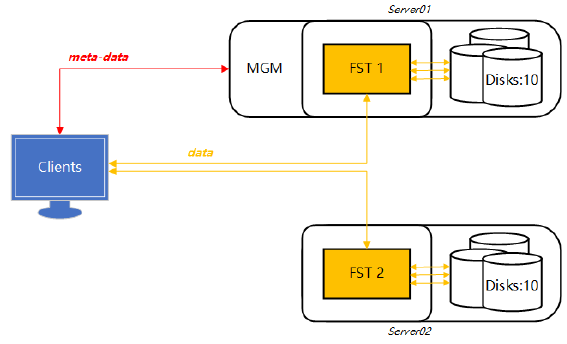
Fig. 2. The development of 2 FSTs in single replica mode